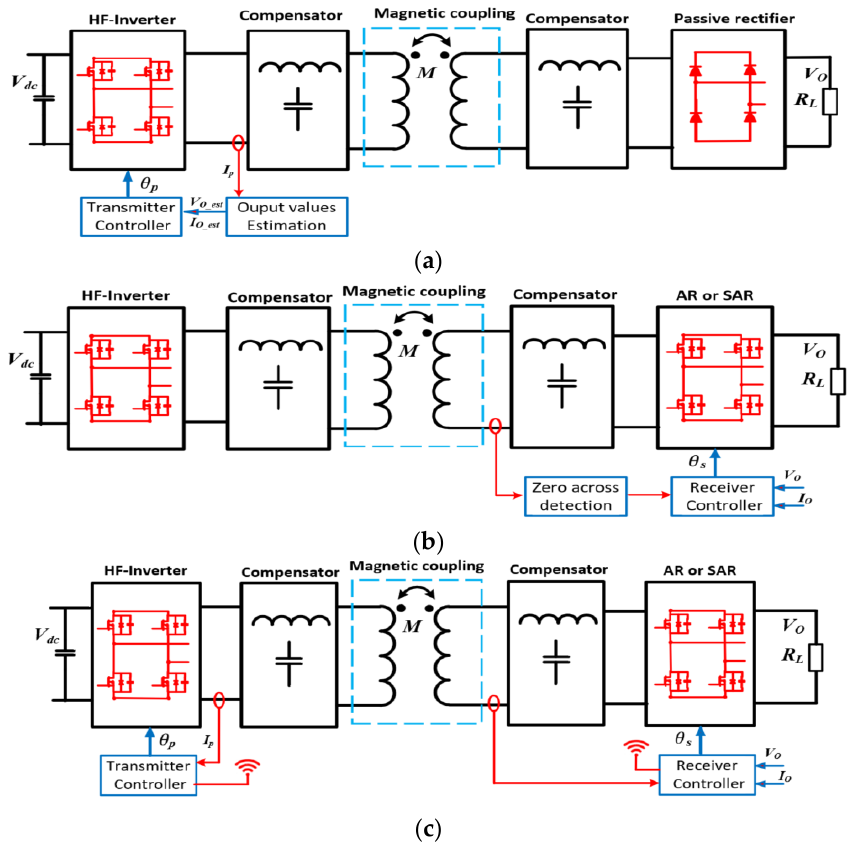
Figure 13. PE structure with phase shift control: ( a ) transmitter side phase shift control, ( b ) receiver- side phase shift control, and ( c ) dual side phase shift